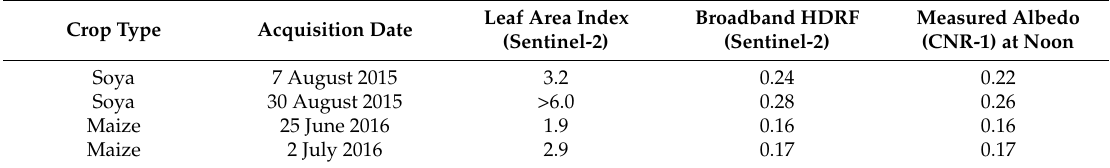
Table 3. Measured albedo (net radiometer) versus broadband HDRF from Sentinel-2 (weighted sum).